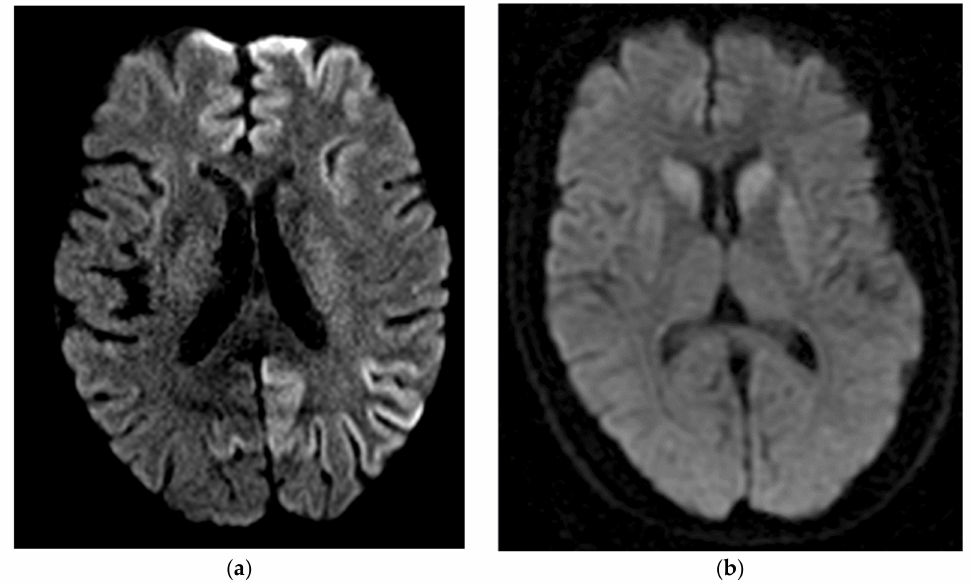
Figure 1. Brain MRI findings in prion disease. ( a ) Axial DWI imaging showing a widespread cortical restricted diffusion pattern typically found in sCJD MM1; ( b ) Axial DWI imaging showing restricted diffusion in the bilateral basal ganglia typically seen in sCJD VV2 (ataxic